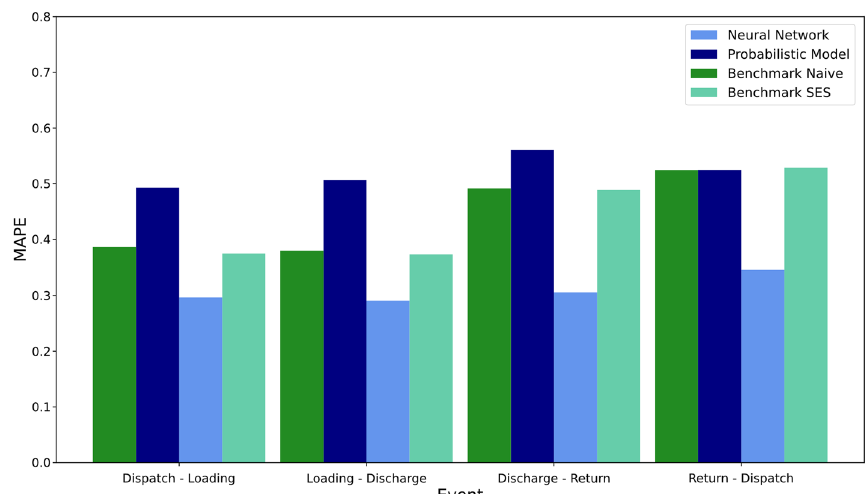
Fig. 12 MAPE of the prediction models over the 18 forecasting origins. Source : Own